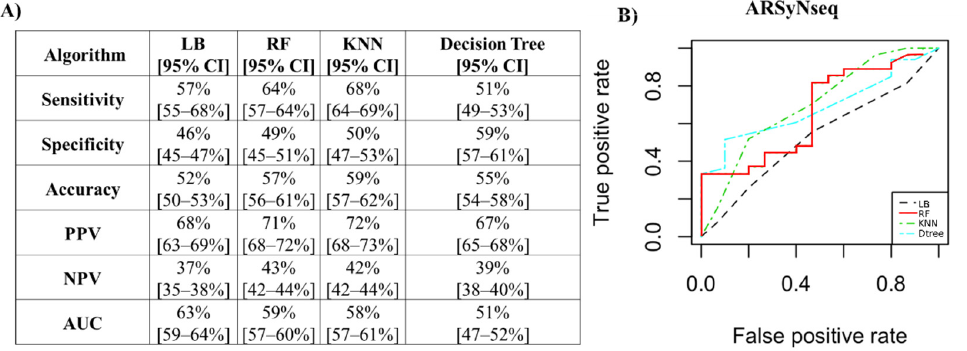
Figure 8. Performance measures to classify patients with positive biopsies for the ARSyNseq method. ( A ) Algorithm performance via PCs to classify patients with positive biopsies for the ARSyNseq method. ( B ) ROC curves of the four classifiers. PPV: positive predictive value; NPV: negative predictive value; AUC: area under the curve; LB: LogitBoost; RF: random forest; KNN: k-nearest neighbors; CI: confidence interval.